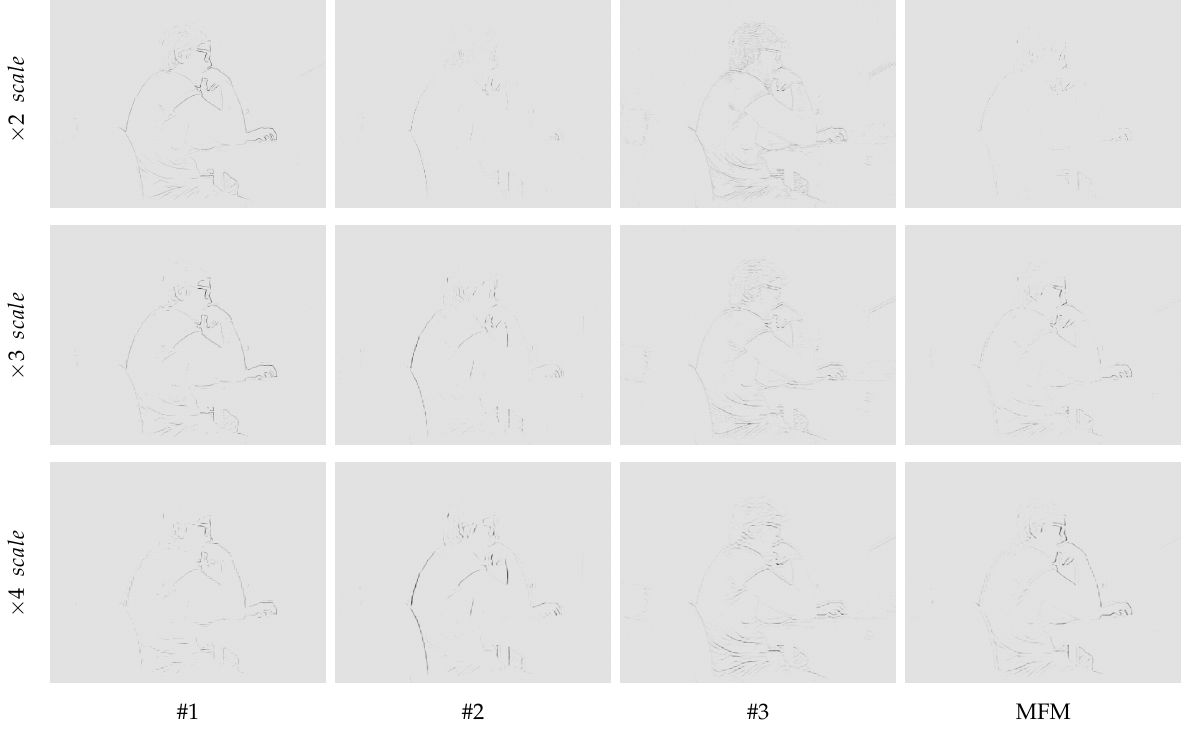
Figure 9. Examples of residual images (row: scale × 2, × 3, and × 4; column: from the #1, #2, and #3 sub-networks and the mixed feature module